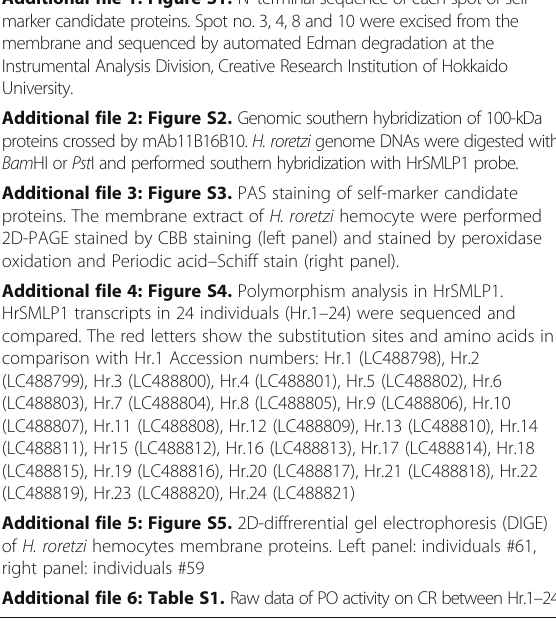
Additional file 5: Figure S5. 2D-diffrerential gel electrophoresis (DIGE) of H. roretzi hemocytes membrane proteins. Left panel: individuals #61, right panel: individuals #59 Additional file 6: Table S1. Raw data of PO activity on CR between Hr.1 –